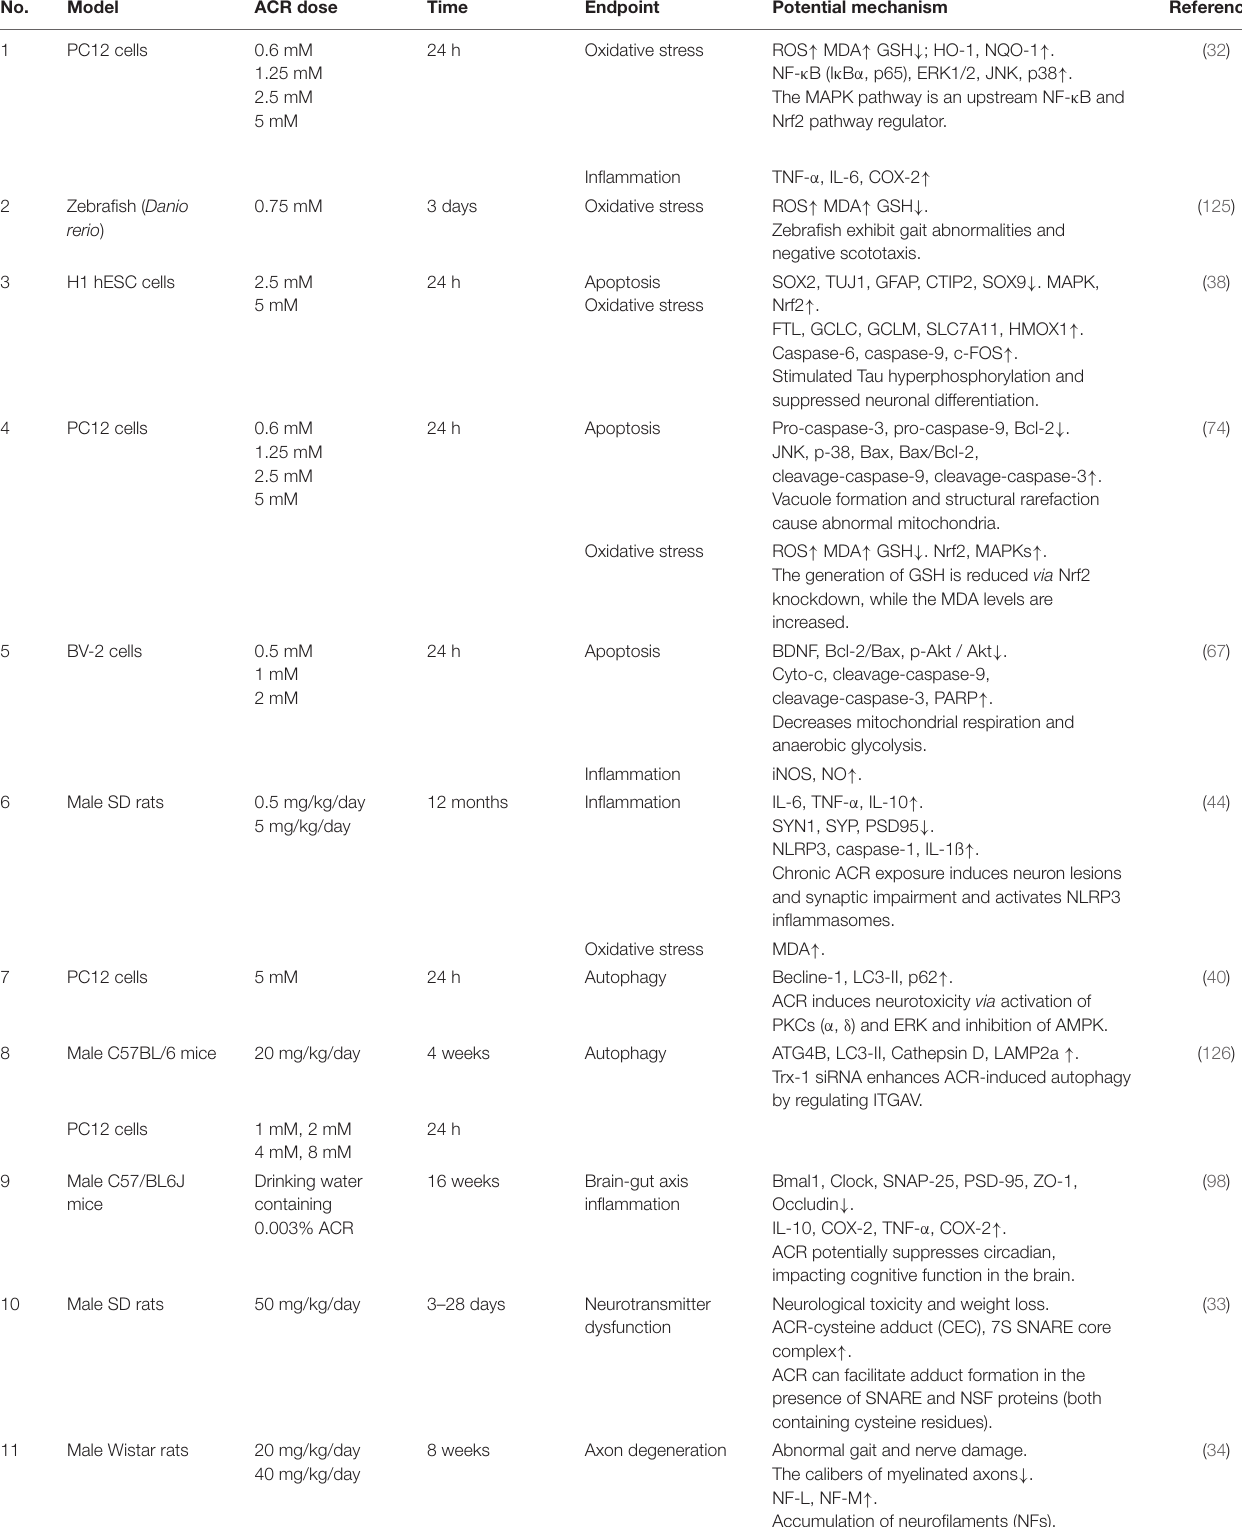
TABLE 2 | A summary of the representative neurotoxic effect of ACR in different models.